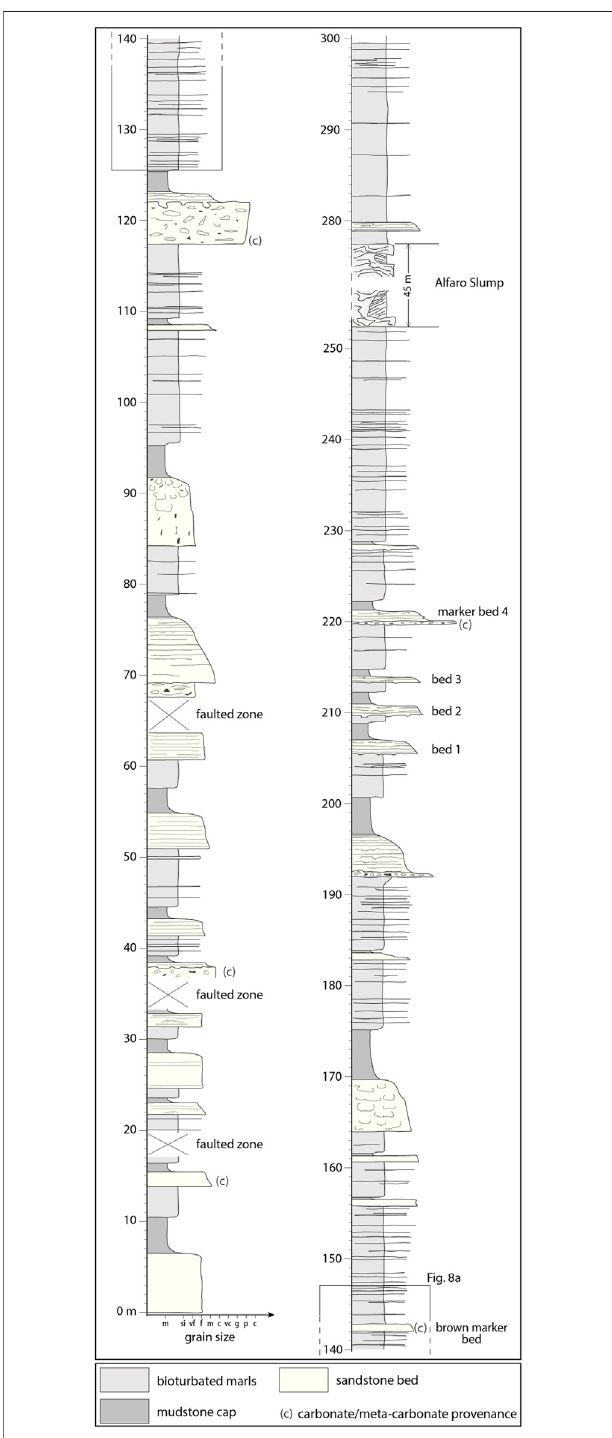
FIGURE 5 | Graphic log showing the character of the Phase 3 succession in the northern part of the Alfaro sub-basin where it is characterised by an expanded succession of thick megabeds and thinner contained turbidites. Log compiled from sections along the old N340 road and the Rambla de Tabernas. Extended from Haughton (2000). The stratigraphic position of the more detailed sections and beds illustrated in Figure 8 is